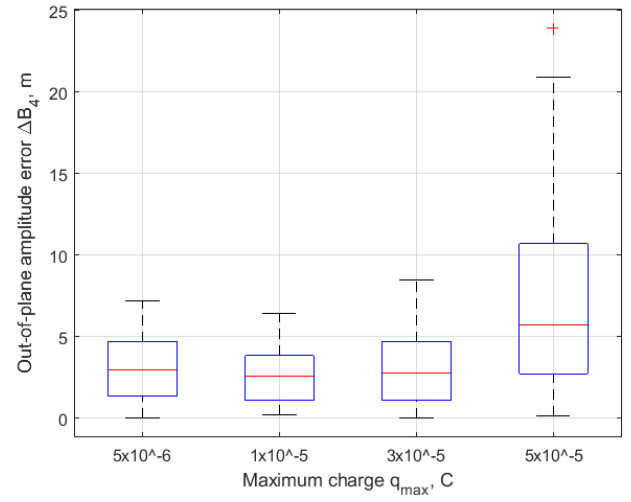
B after convergence. Figure 18. Mean error in B 4 after convergence. 4